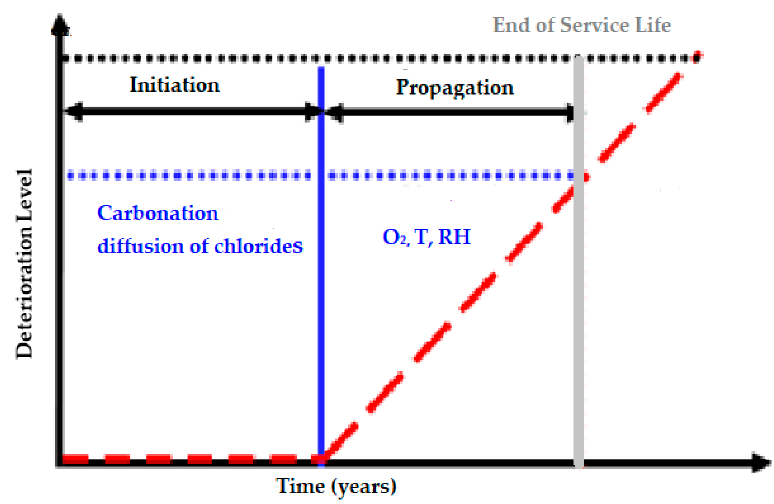
Figure 1. Initiation and Propagation periods given by Tuutti’s model [3].